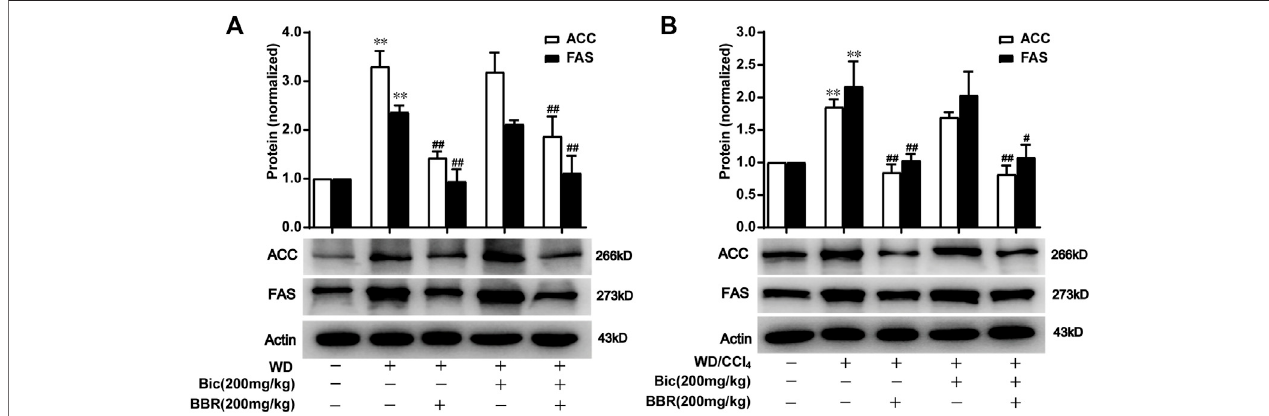
FIGURE 4 | Berberine with or without bicyclol suppresses de novo lipogenesis by inhibiting the protein expression of ACC and FAS. Male C57BL/6J mice were freelyfedwithWDorWDplusbicycloland/or berberine for16 weeks (A) ,orinducedwithWD/CCl 4 for4 weeksandthen treatedwithdrugsfor8 weeks (B) .Theprotein expressionsofACC and FAS weredetected and quanti fi ed. Results were presented asmean± SD, and arepresentative bandwasshown. n= 5 – 9 foreach group, *p < 0.05 and **p < 0.01, the model group vs. control group; # p < 0.05 and ## p < 0.01 vs. the model group. ACC, acetyl-CoA carboxylase; FAS, fatty acid synthase.